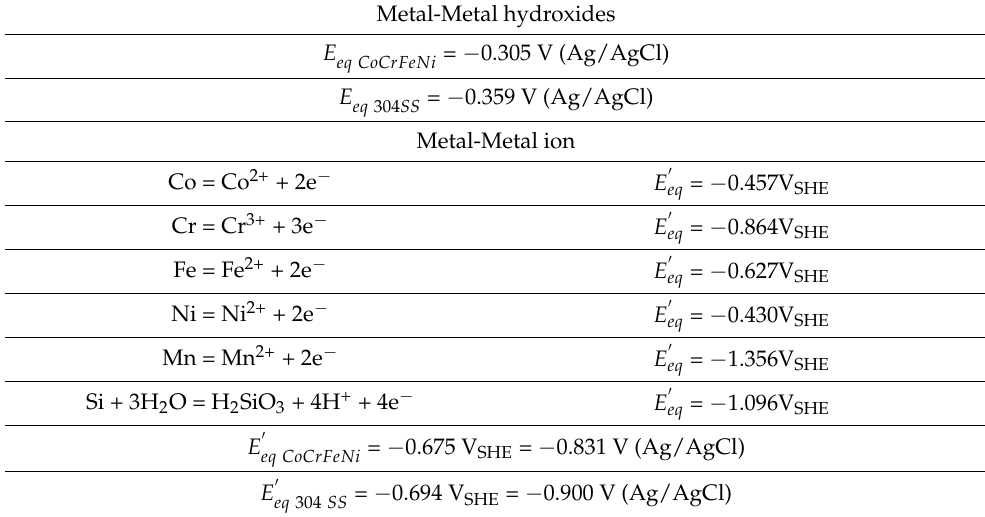
Table 3. The calculated reduction-oxidation equilibrium potentials of metal and metal hydroxides ( E eq ) by Equations (6)–(10) and that ( E’ eq ) of metal and metal ions by Nernst equation, assuming metal ions activity at 10 − 6 M at pH = 0.47 in 0.5 M H 2 SO 4 AAS for CoCrFeNi HEA and 304SS. Metal-Metal hydroxides E = − 0.305 V (Ag/AgCl) eq CoCrFeNi E = − 0.359 V (Ag/AgCl) eq 304 SS Metal-Metal ion Co = Co 2+ + 2e − E (cid:48) eq = − 0.457V SHE Cr = Cr 3+ + 3e − E (cid:48) eq = − 0.864V SHE Fe = Fe 2+ + 2e − Ni = Ni 2+ + 2e −